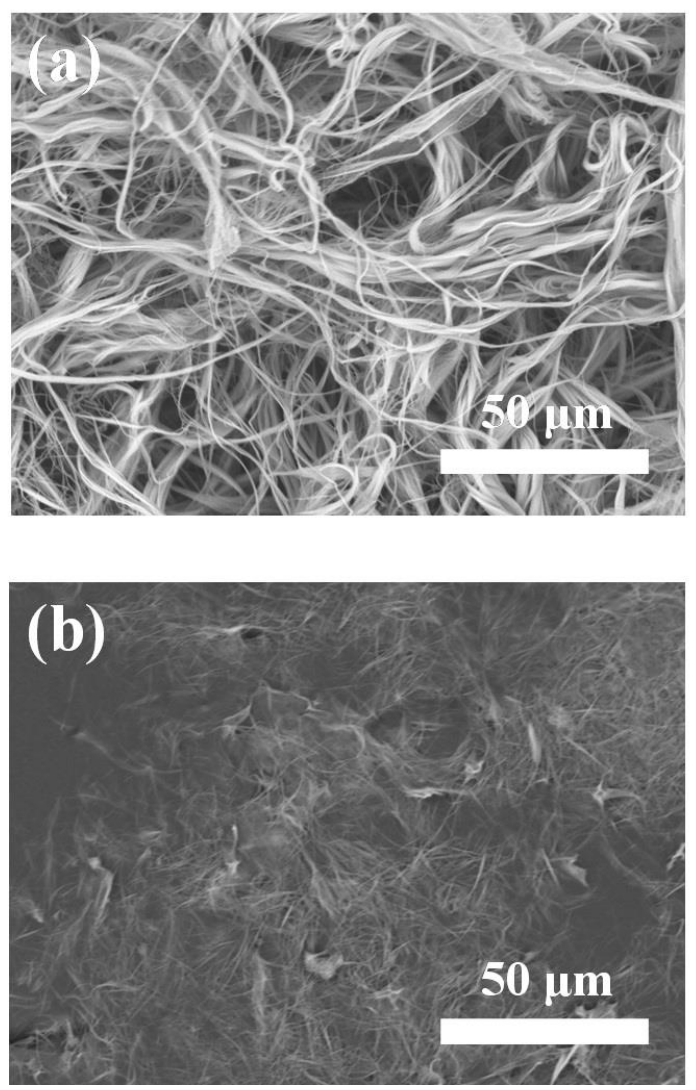
Figure 8. SEM images of the products synthesized using calcium oleate precursor and ATP by the calcium oleate precursor microwave solvothermal method in different reaction systems containing the organic solvent: ( a ) the water/methanol/oleic acid reaction system; ( b ) the water/ethanol/oleic acid reaction system.